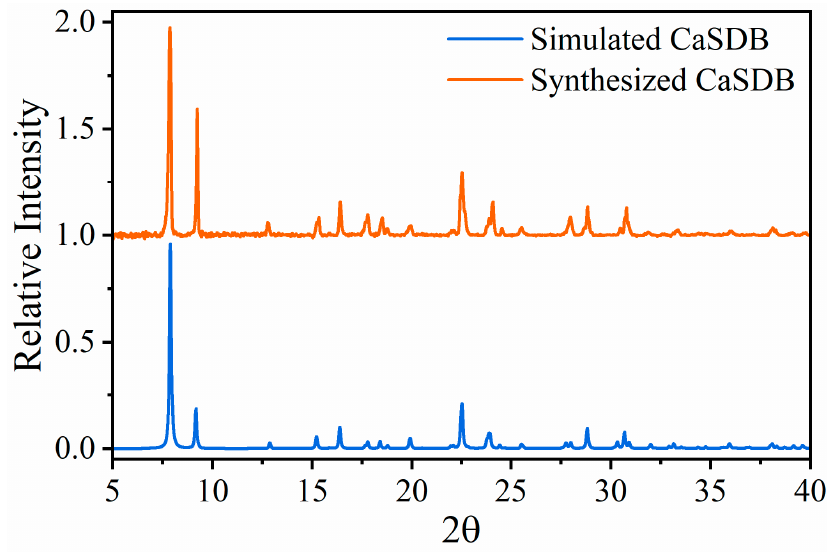
Figure 3. Simulated and experimental XRD measurements of synthesized CaSDB powder.